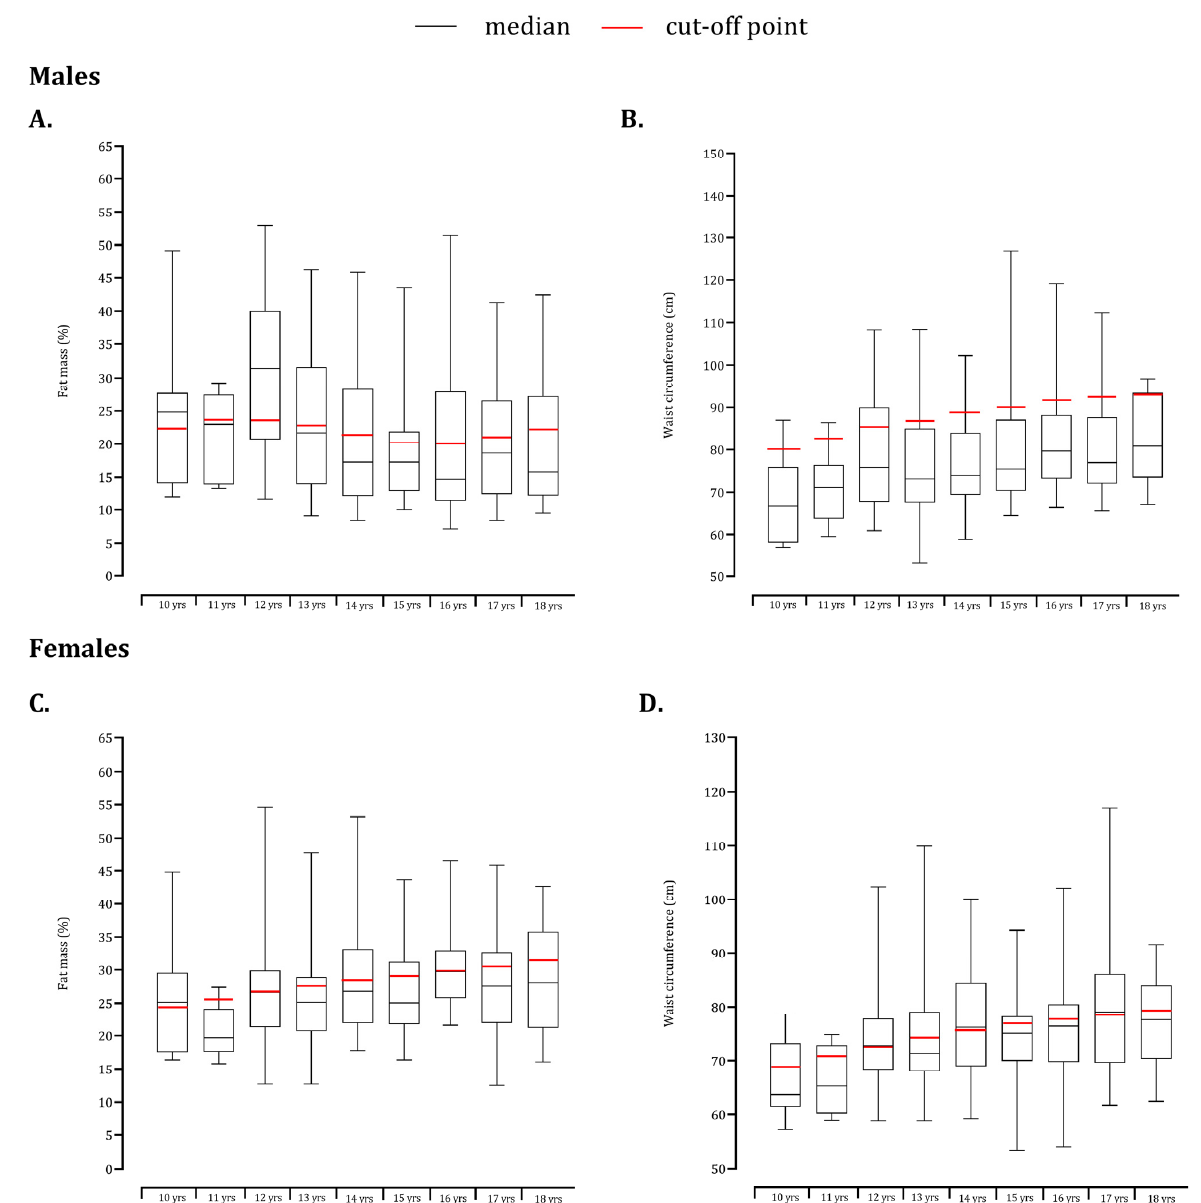
Figure 3. Box and whisker plots of the age-groups plotted relative to cut-off standards for fat mass (males: ( A ); females: ( C )) and waist circumference (males: ( B ); females: ( D )). Among boys, the medians of the number of laps performed in the 20 m shuttle run test were above the cut-off points from 10 to 15 years. However, in late adolescence, the median values were systematically lower than FITESCOLA cut-off points (Figure 4A). The medians of the present study were lower than the 50th percentile found in Portuguese children and adolescents. Sit and reach performance was compared with FITESCOLA and Portuguese-specific data (Figure 4C,D). Among girls, the median number of laps performed in the cardiorespiratory fitness test lagged behind the cut-off points (Figure 5A). In contrast, the horizontal long jump (Figure 5B) and flexibility (Figure 5C,D) tests were above the Portuguese population cut-off points and 50th percentiles.